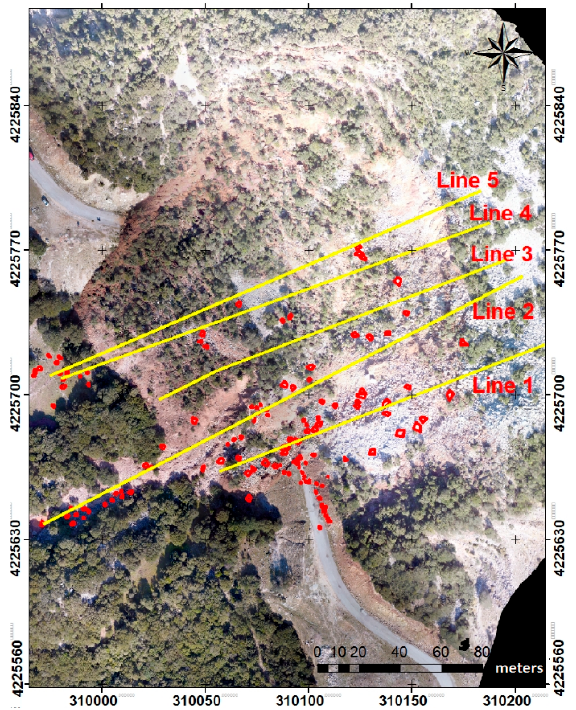
Figure 3. Picture of the rockfall in Moira region, illustrating the final position of rock blocks.